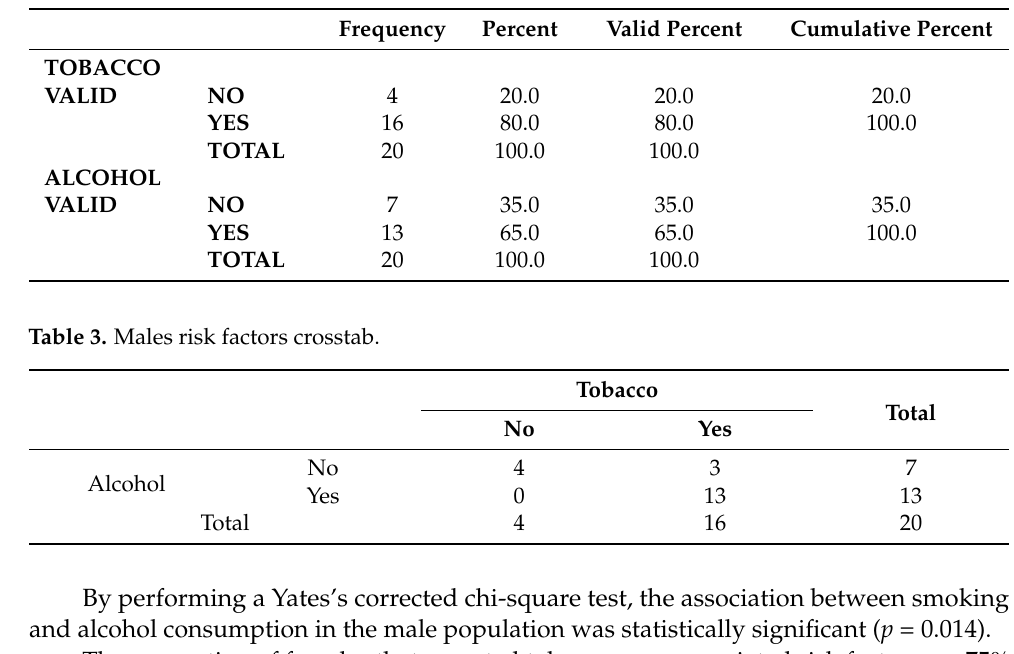
Table 2. Male population and associated risk factors.